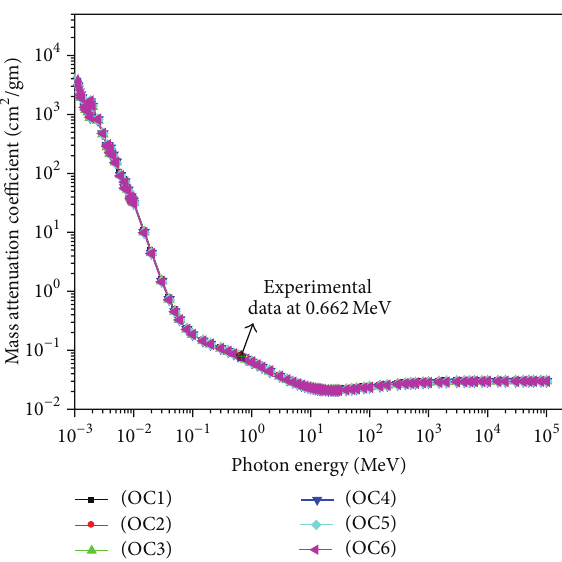
Figure 3: Flexural strength versus age. Table 5: Results of radiation parameters.